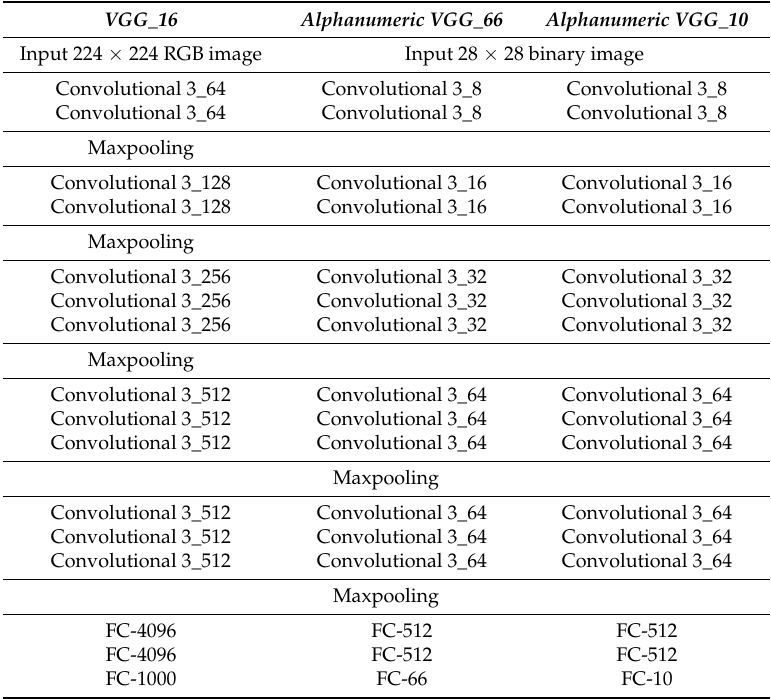
RGB: Red, Green and Blue color model; FC: fully